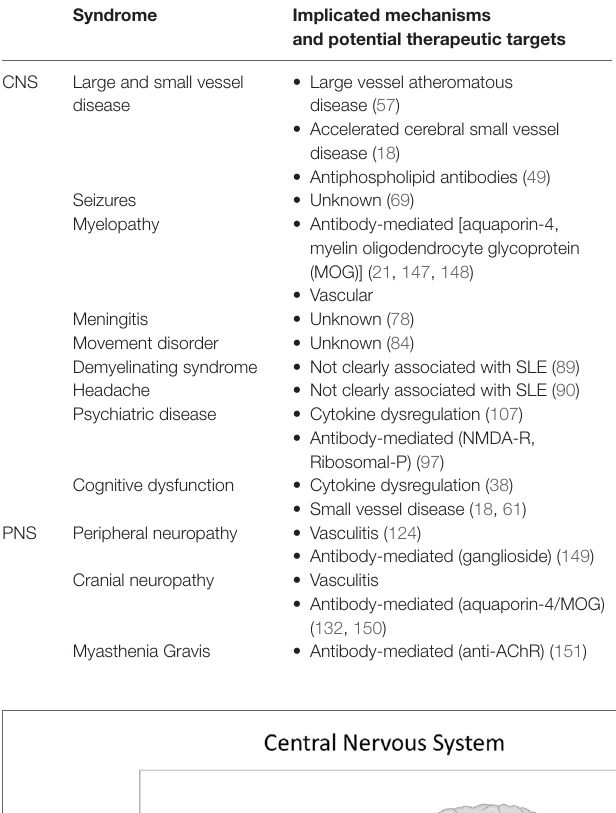
TAbLe 1 | Clinical syndromes seen in people with systemic lupus erythematosus.